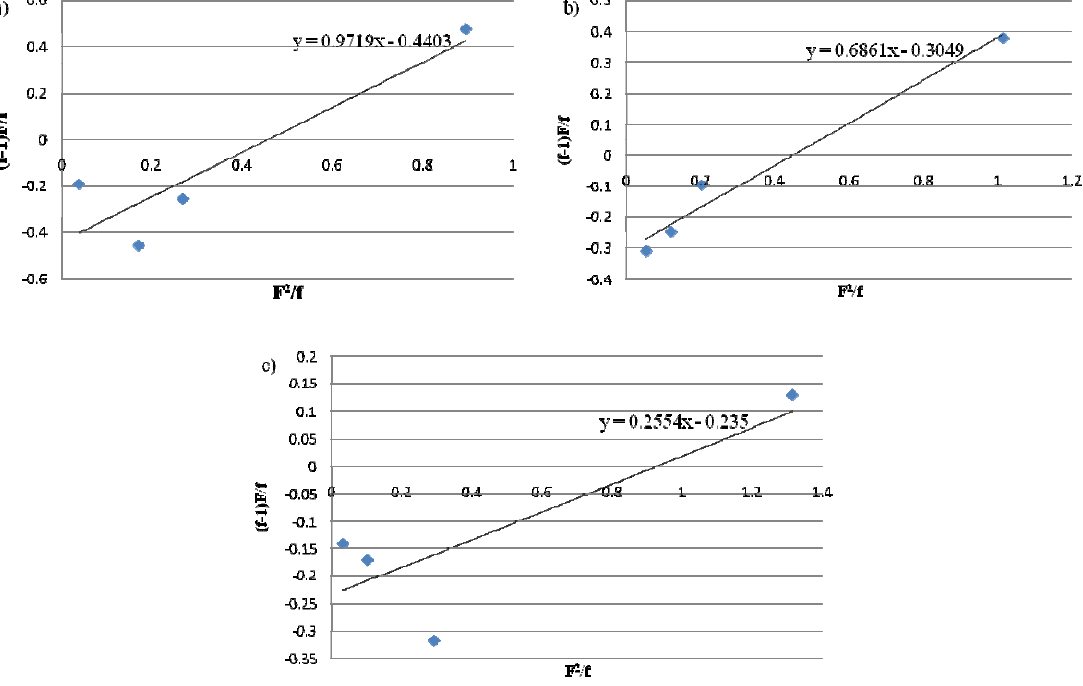
Figure 2. Kelen-TÜdÖs method plots for the copolymers obtained with a ) complex 1 b ) complex 2 and c ) complex 3 where η = G/( α +F’), ξ = F’/( α +F’), G = (f-1)F/f, F’ = F 2 /f, F’ ) 0.5 , F = the mole ratio of ethylene and 1-hexene in the feed and f = the mole α = (F’ max min ratio of ethylene and 1-hexene in the